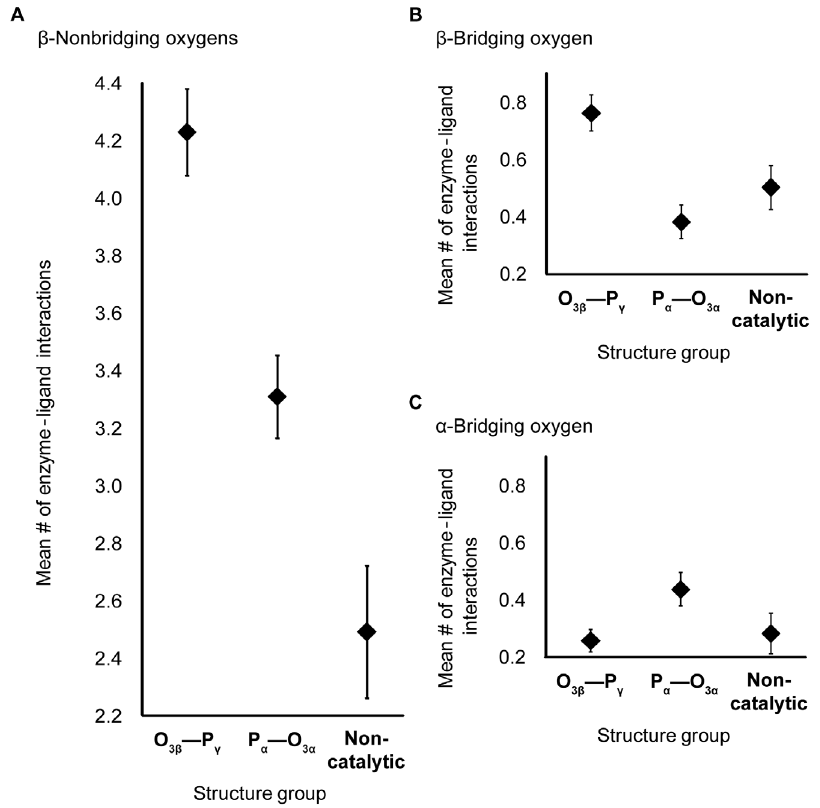
Figure 3. Mean number of enzyme-ligand interactions. Interactions are shown with nonbridging b - (A), bridging b - (B) and bridging a -oxygens (C) in the O 3 b _P c cleaving-, P a _O 3 a cleaving- and non-catalytic-NTP-binding sites. The resolution cutoff of structures used is 2.7 A˚, and water is not included. Bars show standard errors.